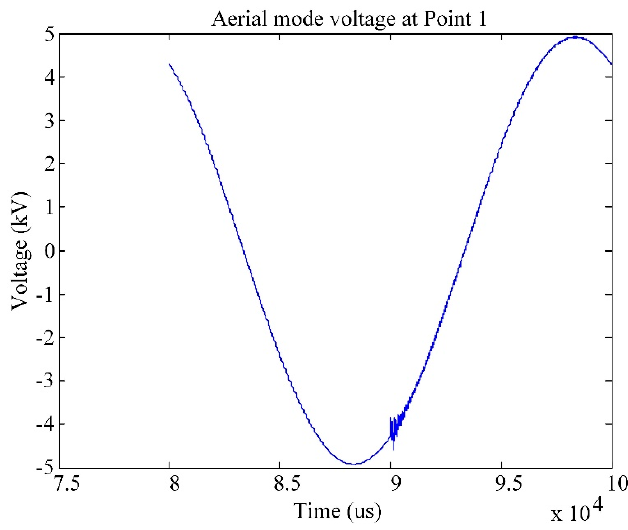
Figure 8. The aerial-mode voltage under 1000 Ω transition resistance.